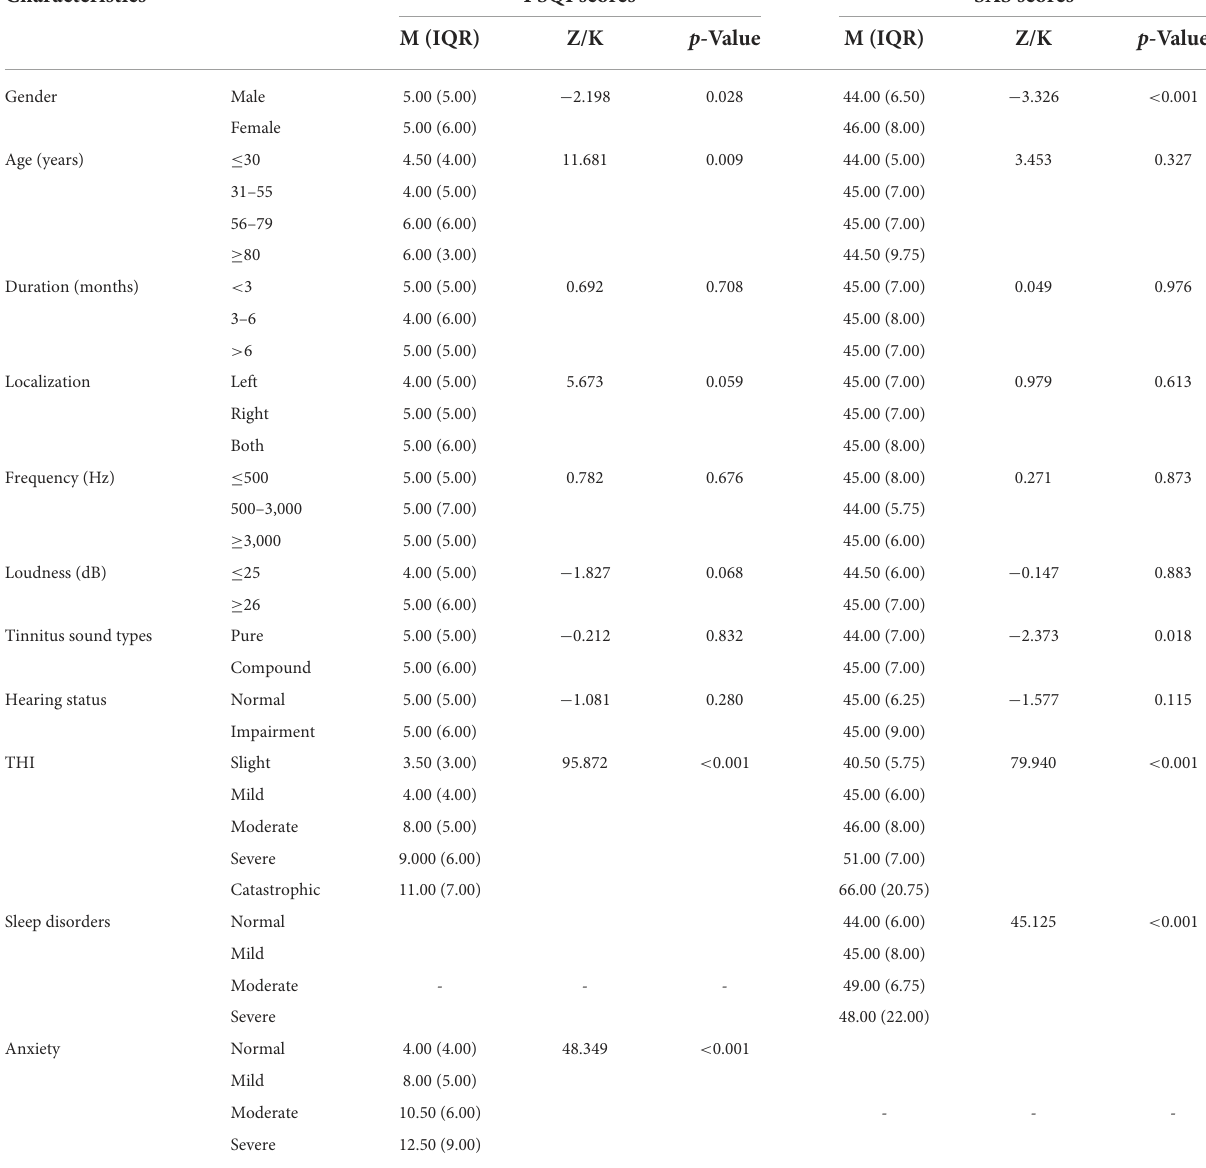
TABLE 2 Relationship between SAS scores, PSQI scores and different characteristics ( n = 393).